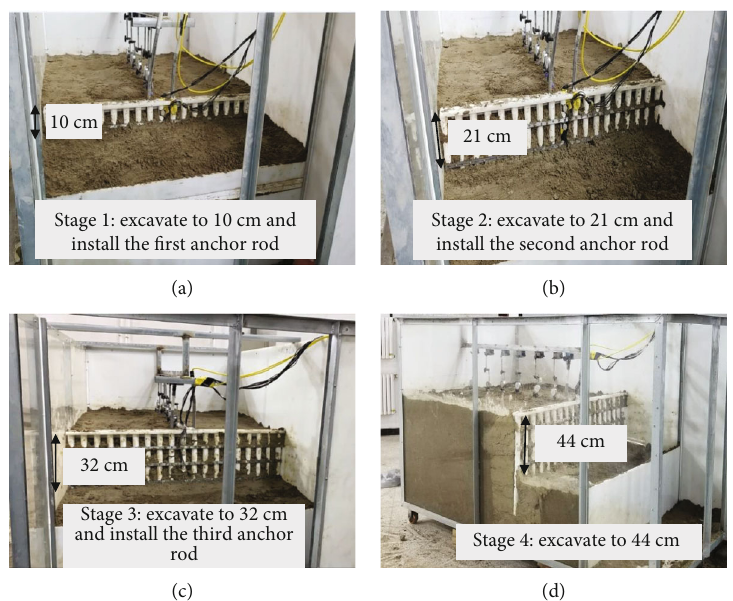
Figure 8: Excavation stage of foundation pit: (a) stage 1; (b) stage 2; (c) stage 3; (d) stage 4.